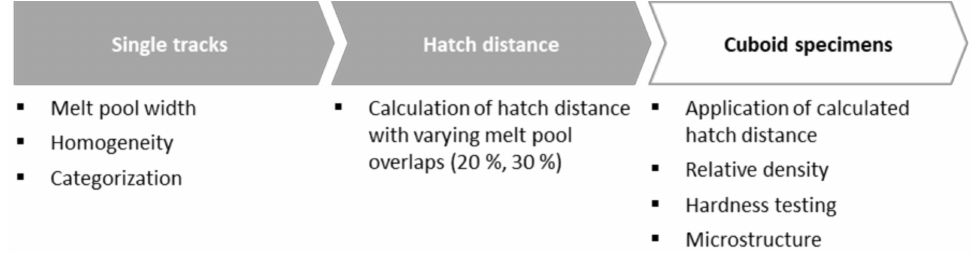
Figure 1. Process flow for determining PBF-LB/M-parameters.